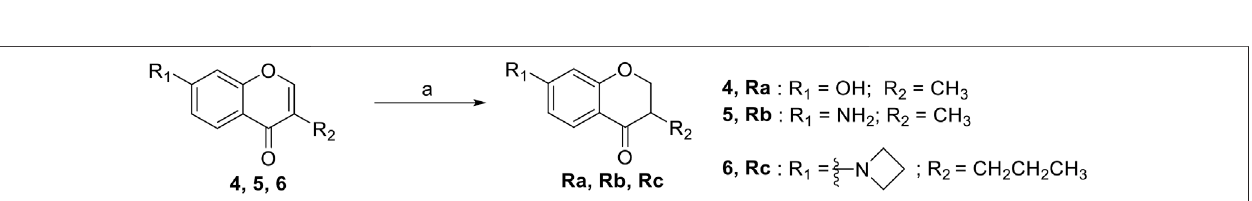
SCHEME 1 | The synthetic route of compounds R1 , R2 , R3 . Reagent and conditions: 10% Pd/C, H 2 , EtOH, RT, Yield: 23.5% (R1) , 15.6% (R2) , 30% (R3) .